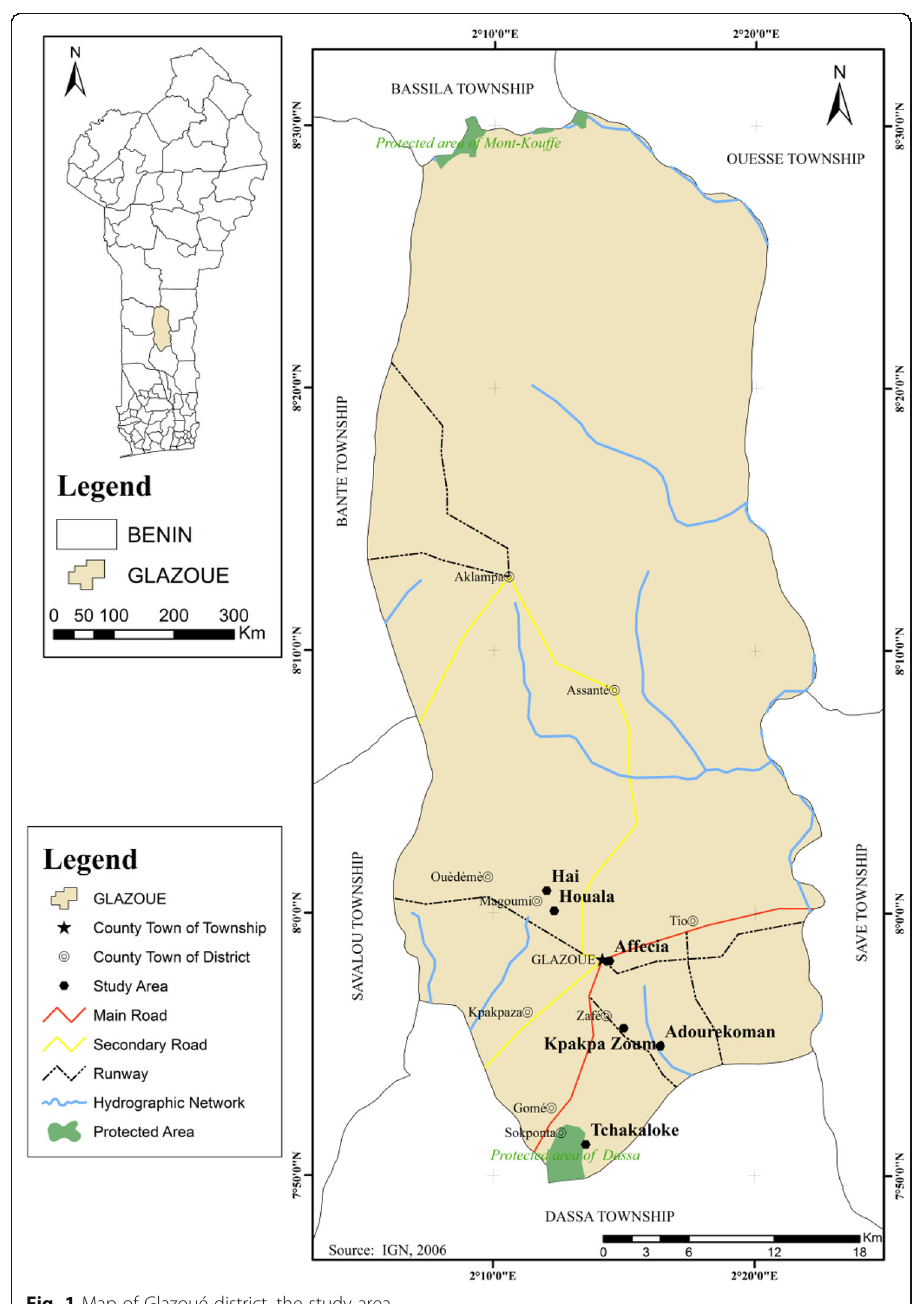
Fig. 1 Map of Glazoué district, the study